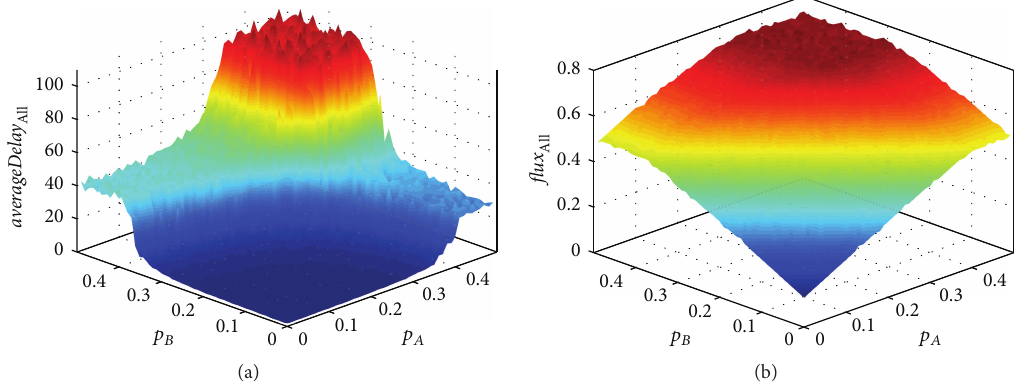
, 𝑝 ) . Assumed the parameter is 𝑝 A B